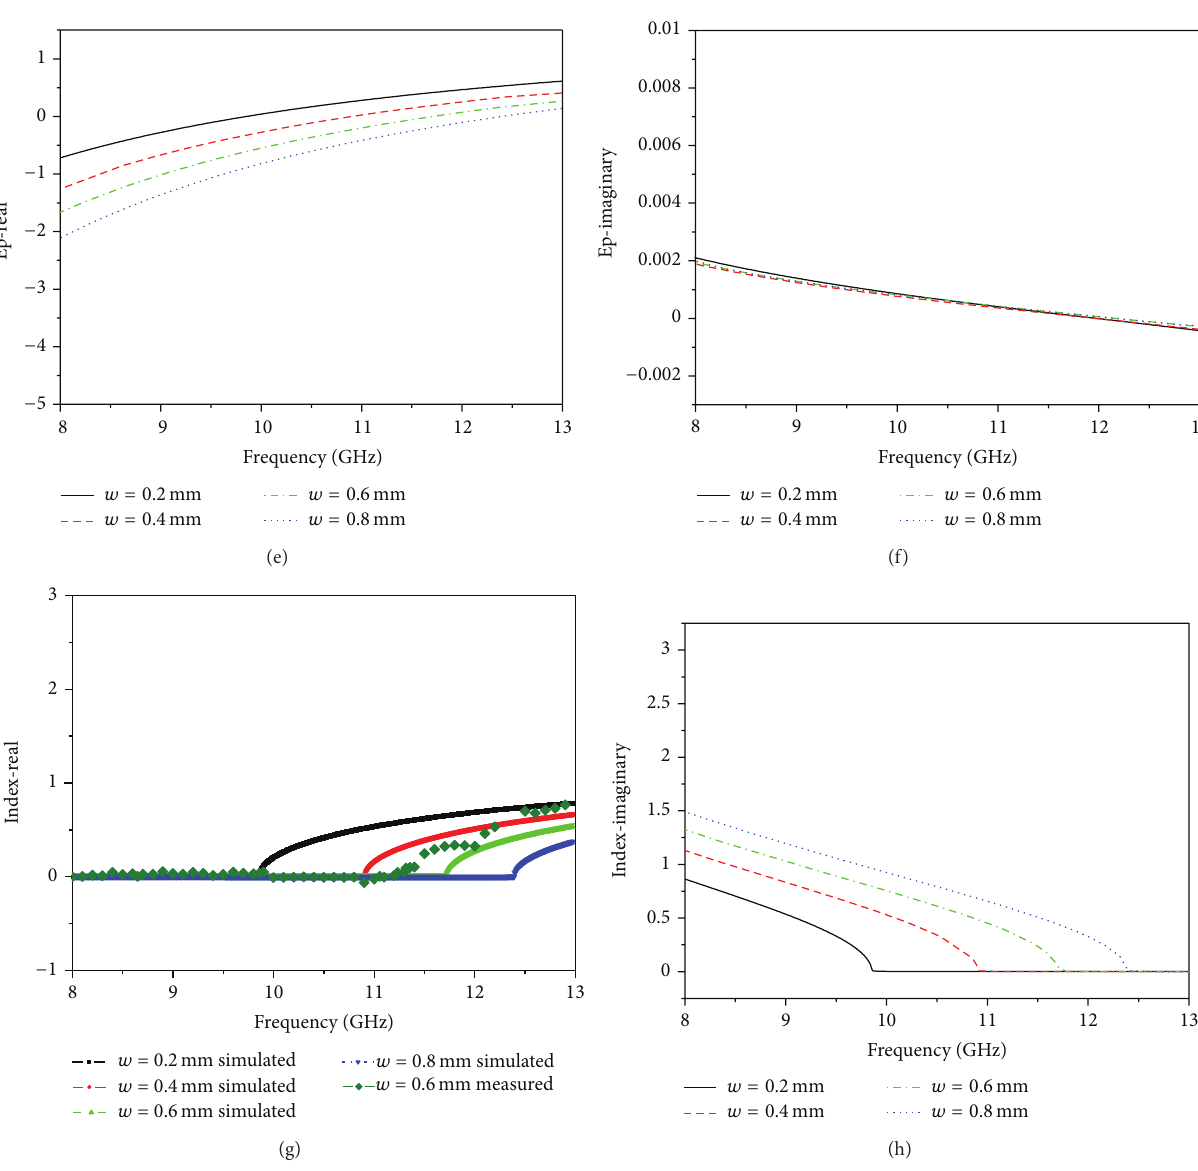
Figure 2: The results for 𝑤 = 0.2 mm, 0.4 mm, 0.6 mm, and 0.8mm with 𝑙 = 14 mm, (a) the simulated transmission spectrums, (b) the simulated reflection spectrums, (c) the simulated real parts of the permeability, (d) the simulated imaginary parts of the permeability, (e) the simulated real parts of the permittivity, (f) the simulated imaginary parts of the permittivity, (g) the simulated and measured real parts of the index, and (h) the simulated imaginary parts of the